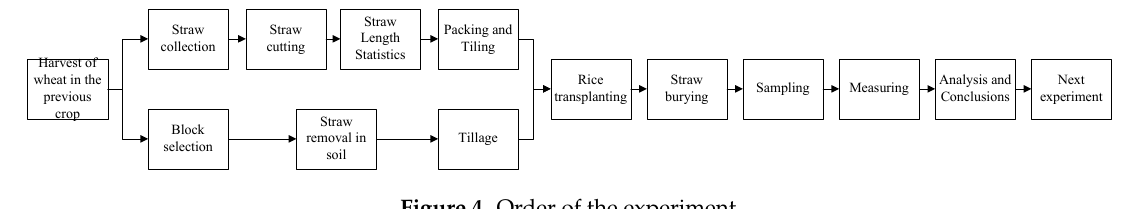
Figure 3. Field layout.